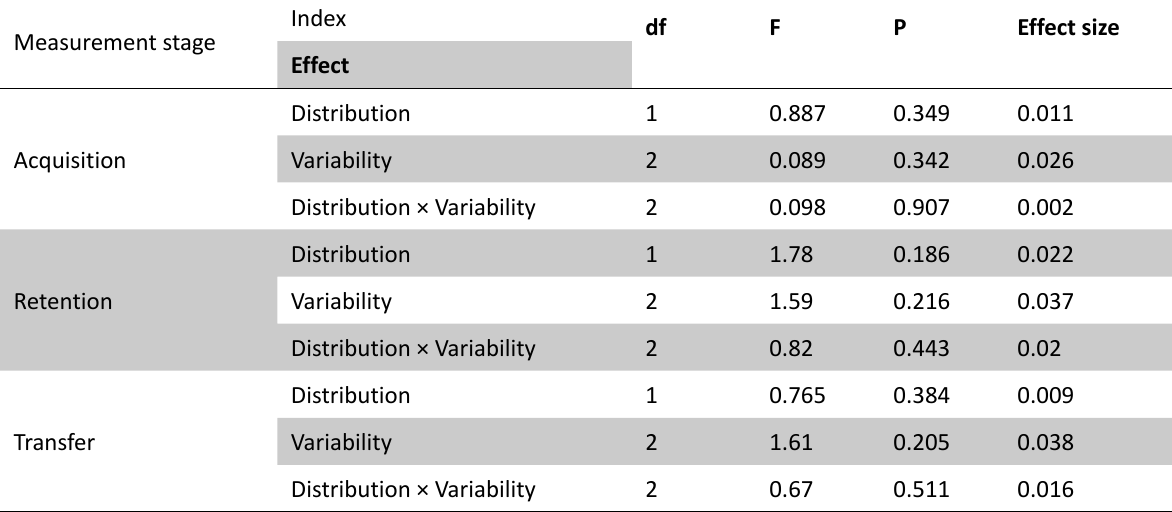
Table 1. Results of multivariate ANOVA in different stages of